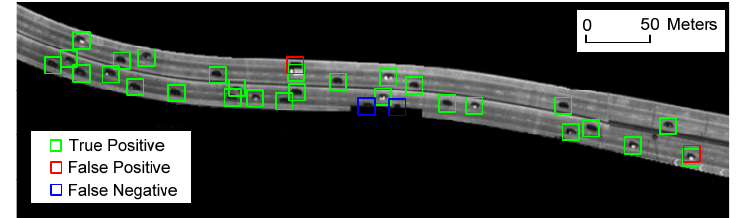
Figure 16. Moving vehicle detection results of Scene 9.